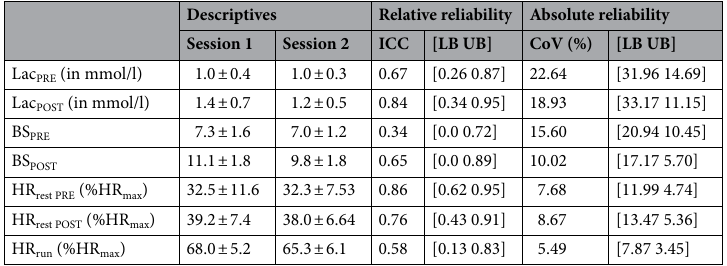
Table 1. Overview of results revealed from reliability analysis for physiological outcomes before and after 10 min of running on the treadmill. Data are presented as outcome means ± standard deviations, Intraclass- Correlation-Coefficients (ICC) and Coefficient of Variation (CoV) including lower (LB) and upper bound (UB) of the 95% confidence interval of two sessions performed within 1 week and statistical outcomes of repeated measures ANOVA with the factors Exercise (PRE vs. POST) and Session (Session I vs. Session II) performed at p < 0.05. Blood lactate values (Lac) obtained from the right earlobe and rate of perceived exertion (RPE) were assessed before (PRE) and immediately after (POST) running on the treadmill. Average resting heart rate (HR rest ) is determined as the 5-min average heart rate (HR) recorded in a sitting position, HR in running (HR run ) is obtained as the average HR during 10-min of running at 50% of the individual VO 2peak . HR measures are presented as the percentage of the individual HR max